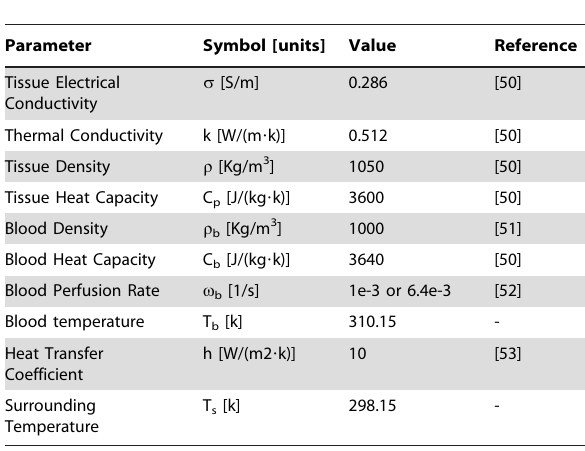
Table 2. Parameters used for numerical